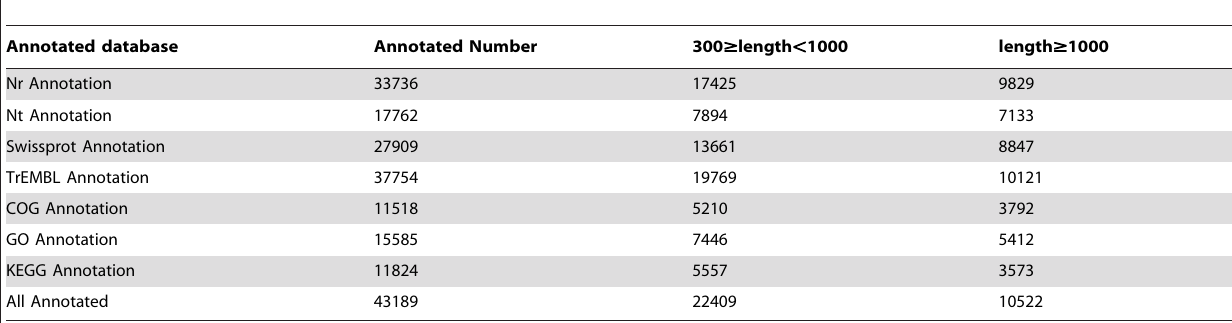
Table 3. Functional annotation of A. lepigone